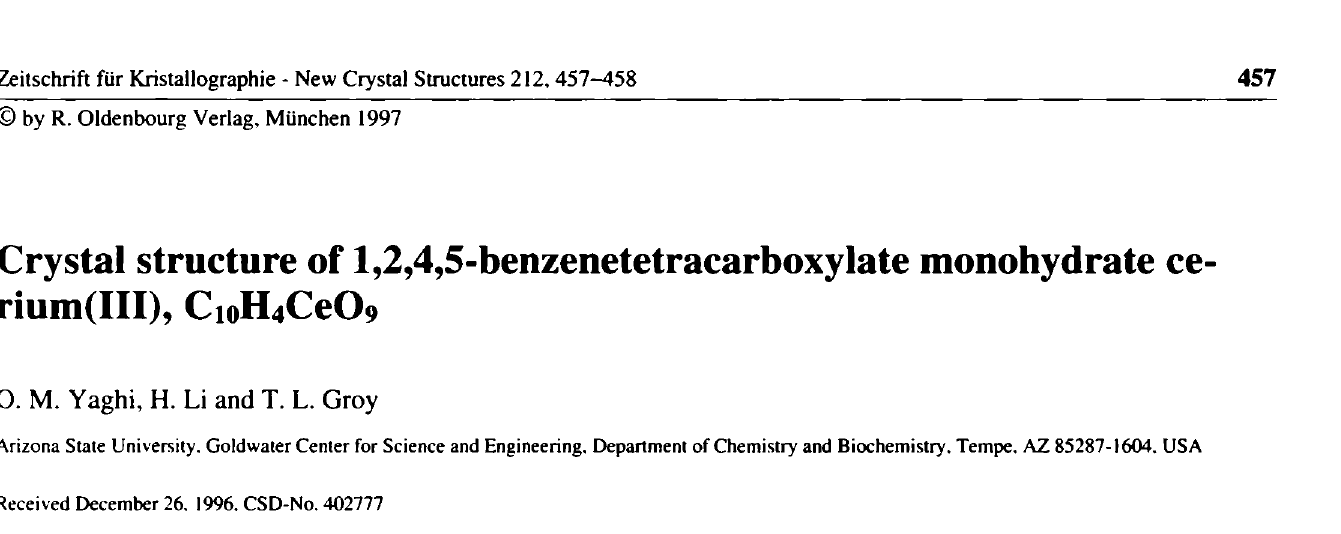
Table 1. Parameters used for the X-ray data collection